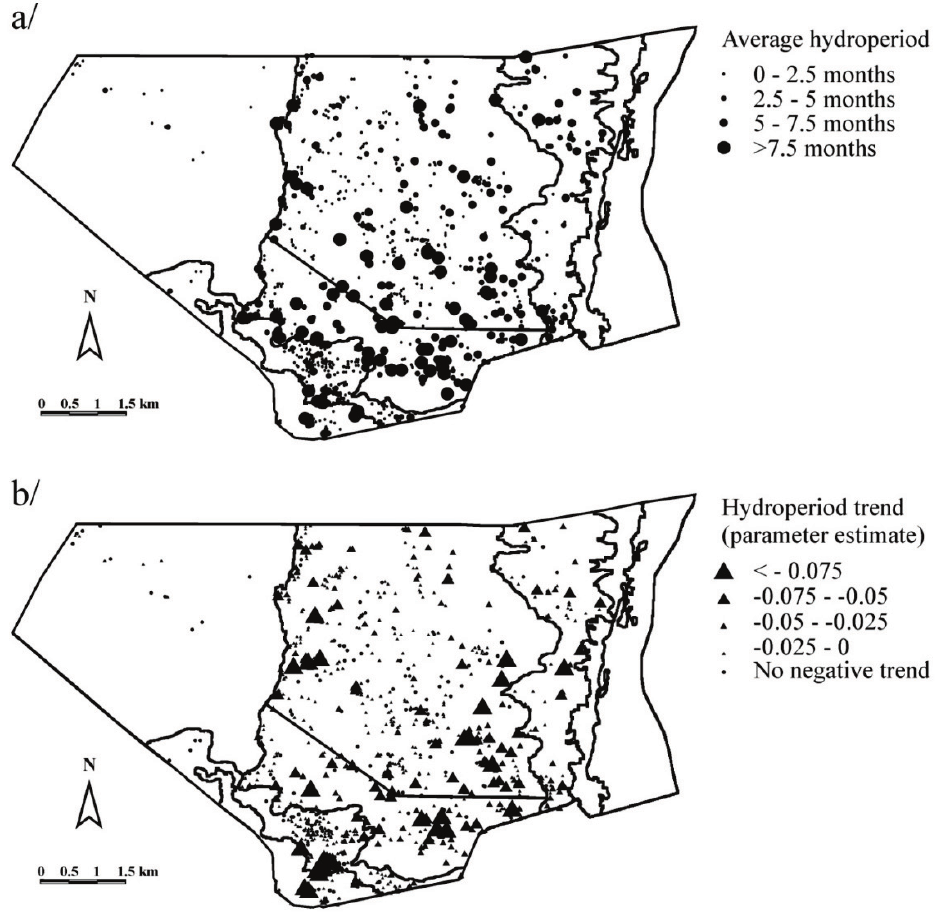
Figure 5. (a) Cartography of average hydroperiod (frequency of water occurrence) over the entire study period. (b) Cartography of the trend in annual hydroperiod for each temporary pond over the entire study period. Hydroperiod trend is estimated as the slope of the regression between annual hydroperiod and year